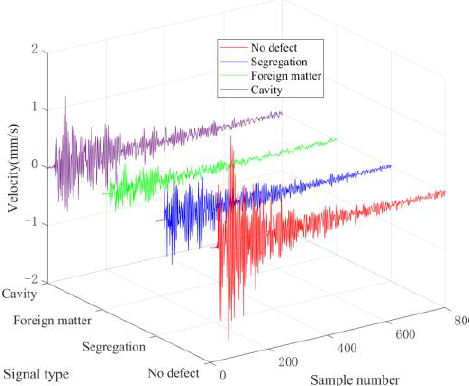
Figure 4. Four typical types of concrete waveforms.